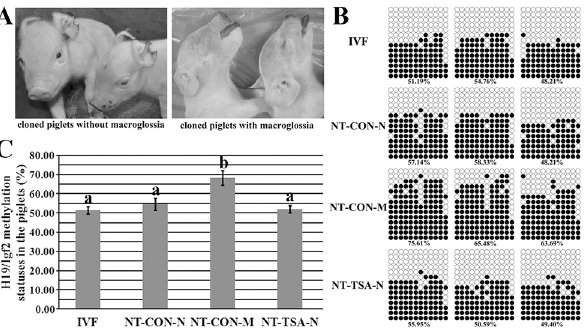
Fig 4. H19/Igf2 methylation statuses in piglets. A, cloned piglets without or with macroglossia, B and C, methylation statuses of H19/Igf2 in cloned piglets. IVF, the IVF piglets, NT-CON-N, normal cloned piglets in the NT-CON group, NT-CON-M, cloned piglets with macroglossia in the NT-CON group, and NT-TSA-N, normal cloned piglets in the NT-TSA group. TSA prevented the disrupted imprinting of H19/Igf2 and macroglossia occurrence of cloned piglets. Black or white circles indicate methylated or unmethylated CpG sites, respectively. The data were expressed as mean ± SEM. a-b Values with different superscripts differ significantly (P <